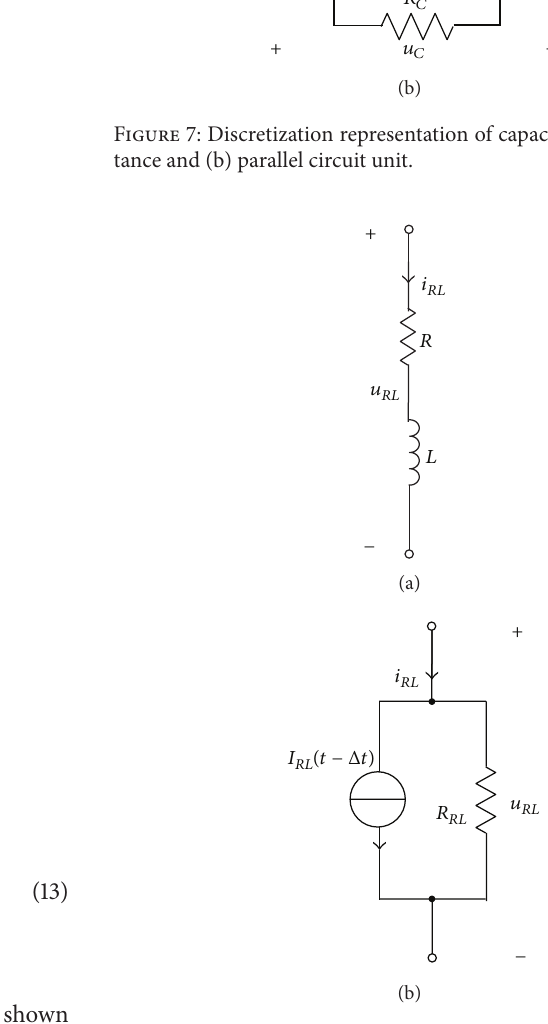
Figure 8: Discretization representation of 𝑅 - 𝐿 branch. (a) 𝑅 - 𝐿 branch and (b) parallel circuit